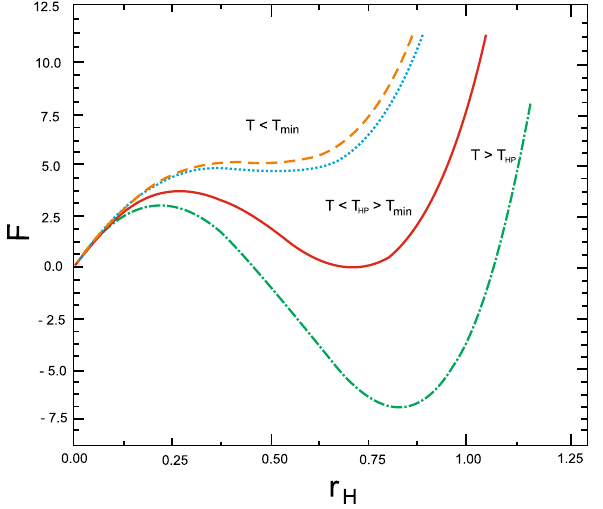
Fig. 5 Graphs of F × r H for positive cosmological constant with = 0 . 00909823501, T T H min 0 . 42359355918 considering (cid:2) = 0 . 5 and N = 1 . 5